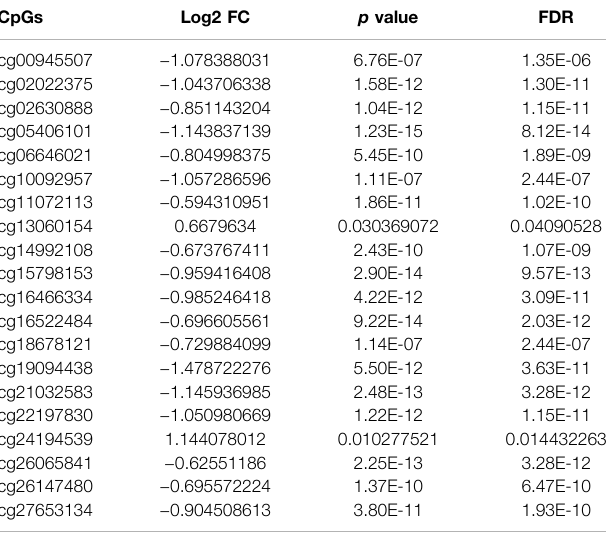
TABLE 2 | Characteristics of the differential prognosis-related CpGs by wilcoxon rank-sum test (cluster 5 vs. the rest clusters). CpGs